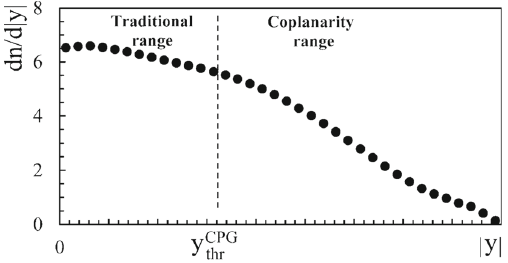
Fig. 2 A qualitative scheme of traditional and coplanarity ranges of dn ch / dy